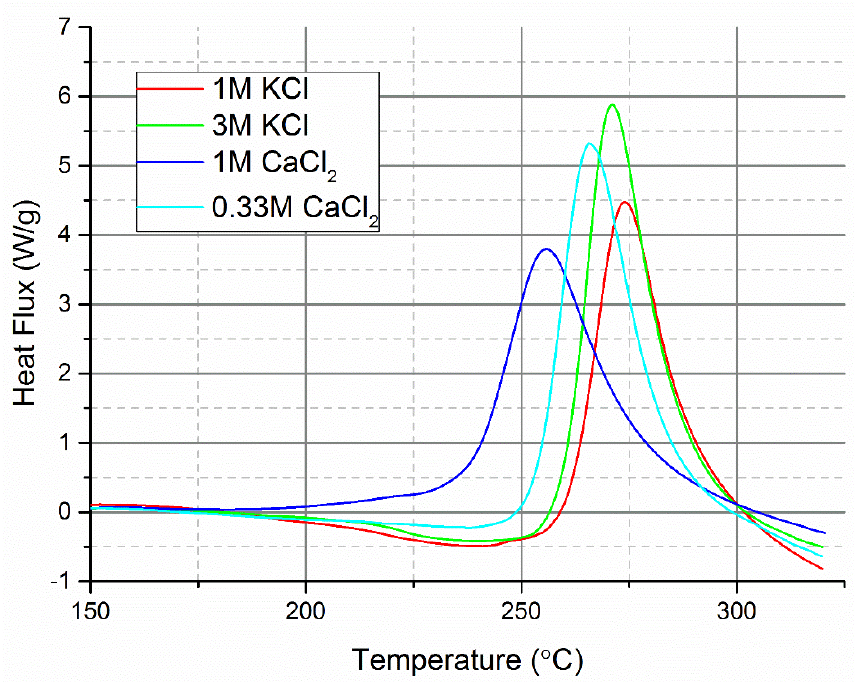
Figure 4. The effect of ionic strength on the HTC of cellulose measured by DSC using two neutral pH chloride salts.